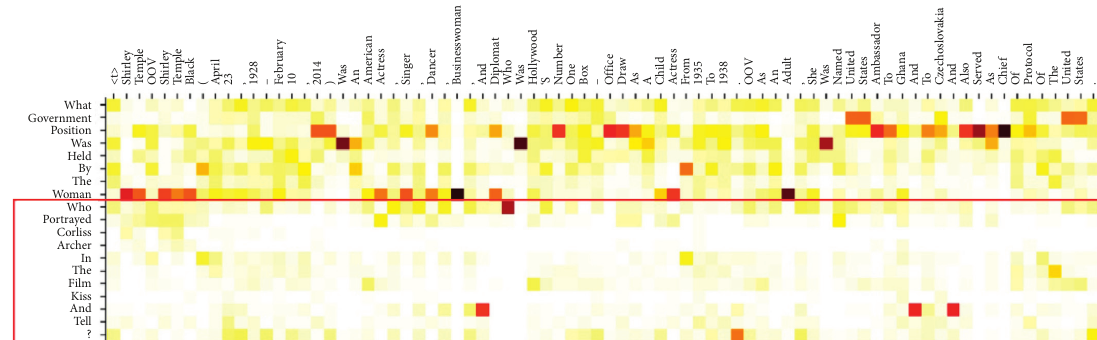
Figure 6: Attention heat map of the dual/sup model.